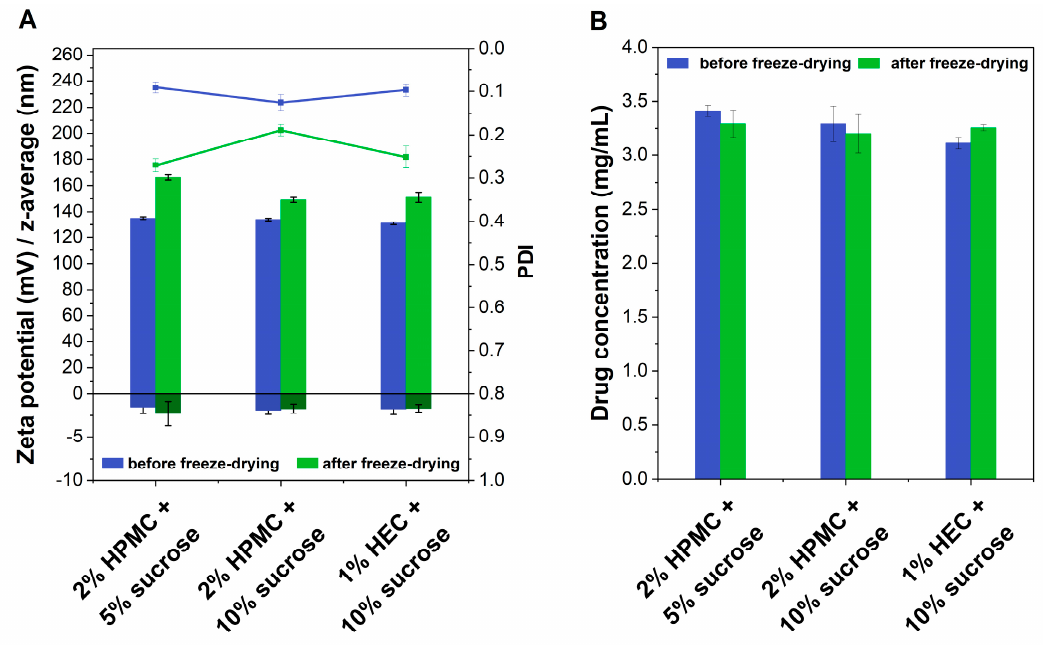
Figure 1. Comparison of three different formulation approaches using various celluloses before and after freeze-drying with ( A ) presenting the physicochemical characteristics including particle size (left axis, light green and blue bars), zeta potential (left axis, dark green and blue bars), and PDI (green and blue line) and ( B ) indicating the drug content (Mean ± SD, n = 3). Hence, this formulation (2% HPMC, 10% sucrose) was selected for further investiga- tion. The reproducibility of the manufacturing process regarding the physical stability and drug content is presented in Figure